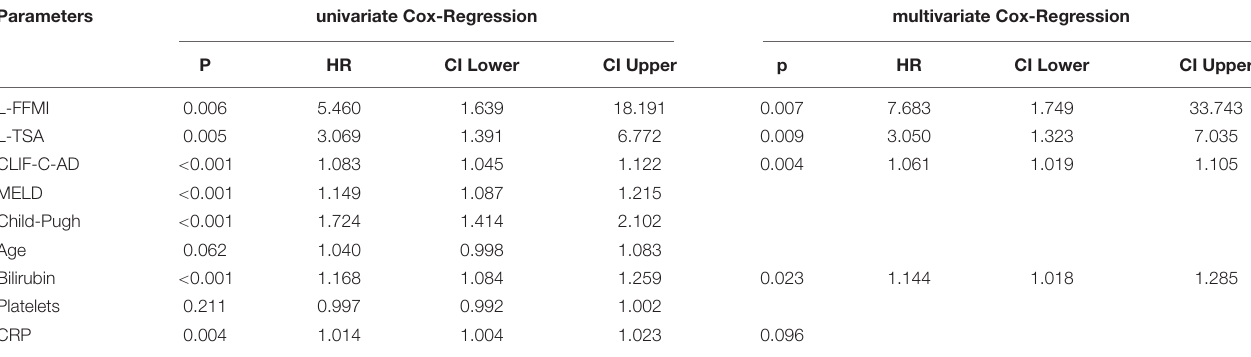
TABLE 3 | Univariate/multivariate Cox regression analysis for 1-year mortality. Parameters univariate Cox-Regression multivariate Cox-Regression